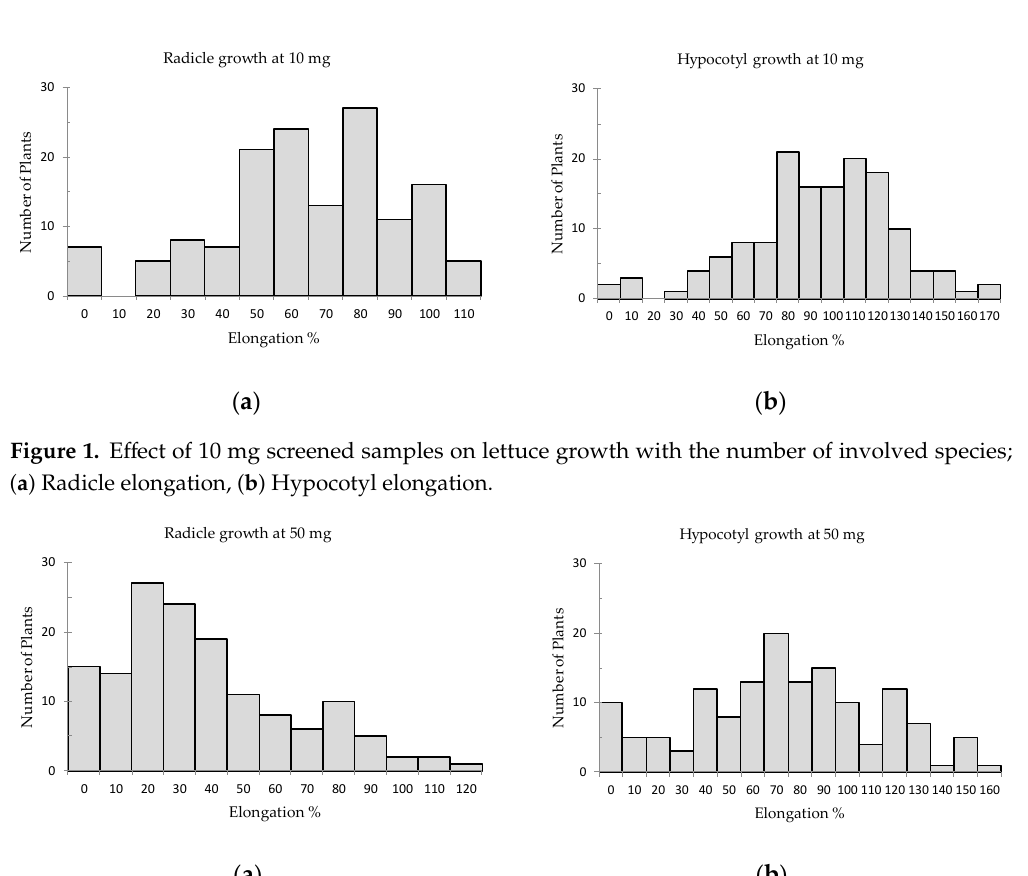
Figure 2. Effect of 50 mg screened samples on lettuce growth with the number of involved species; ( a ) Radicle elongation, ( b ) Hypocotyl elongation.